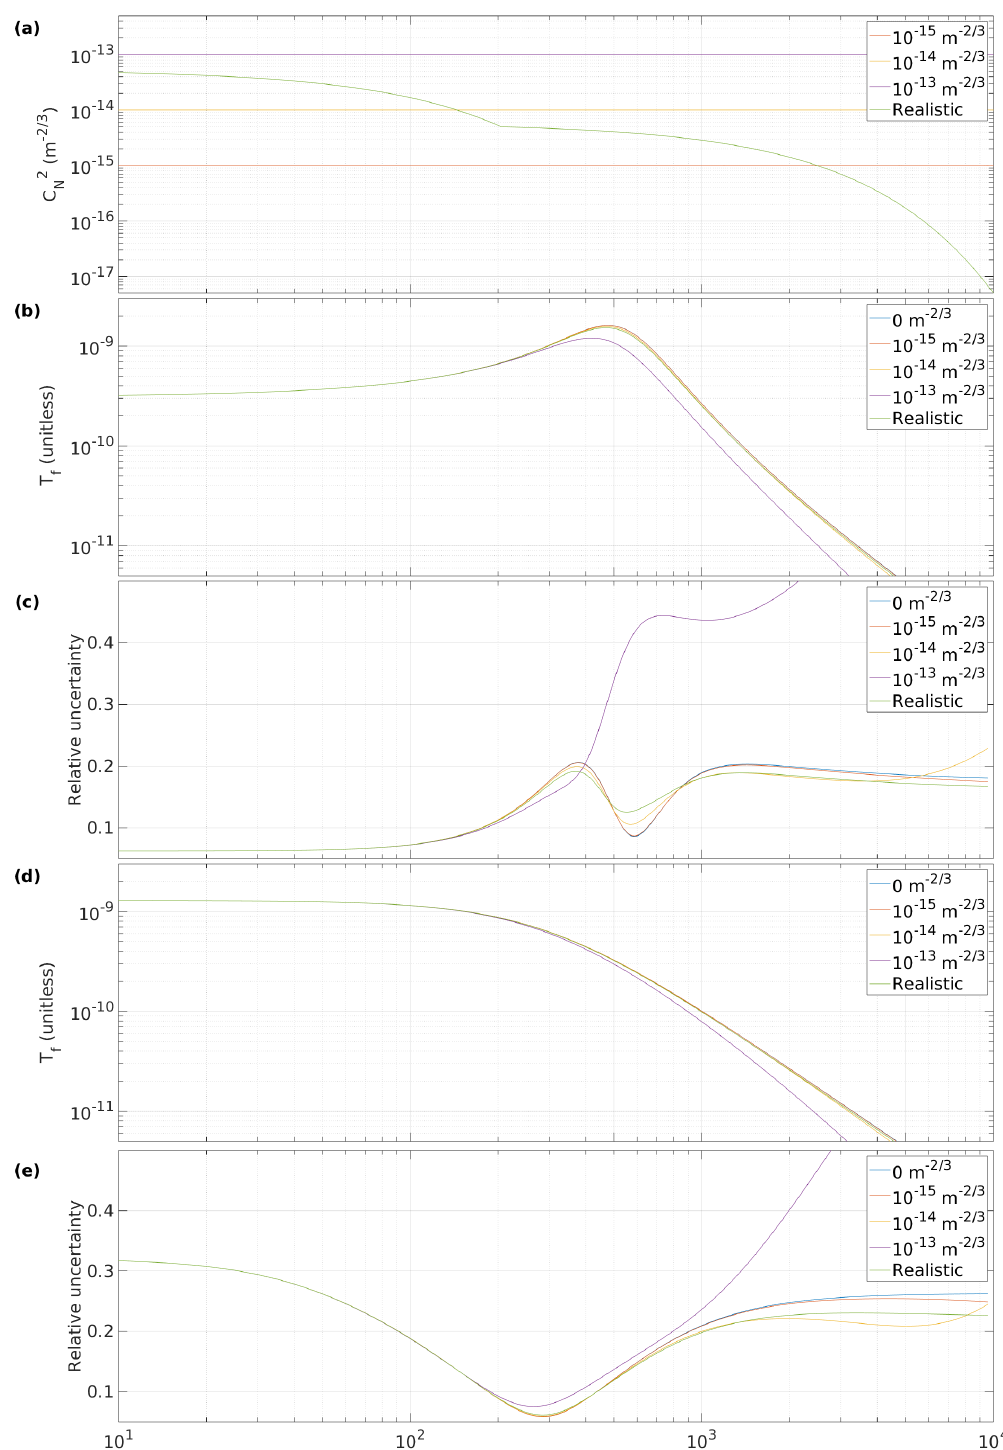
(R) , for different C n 2 f